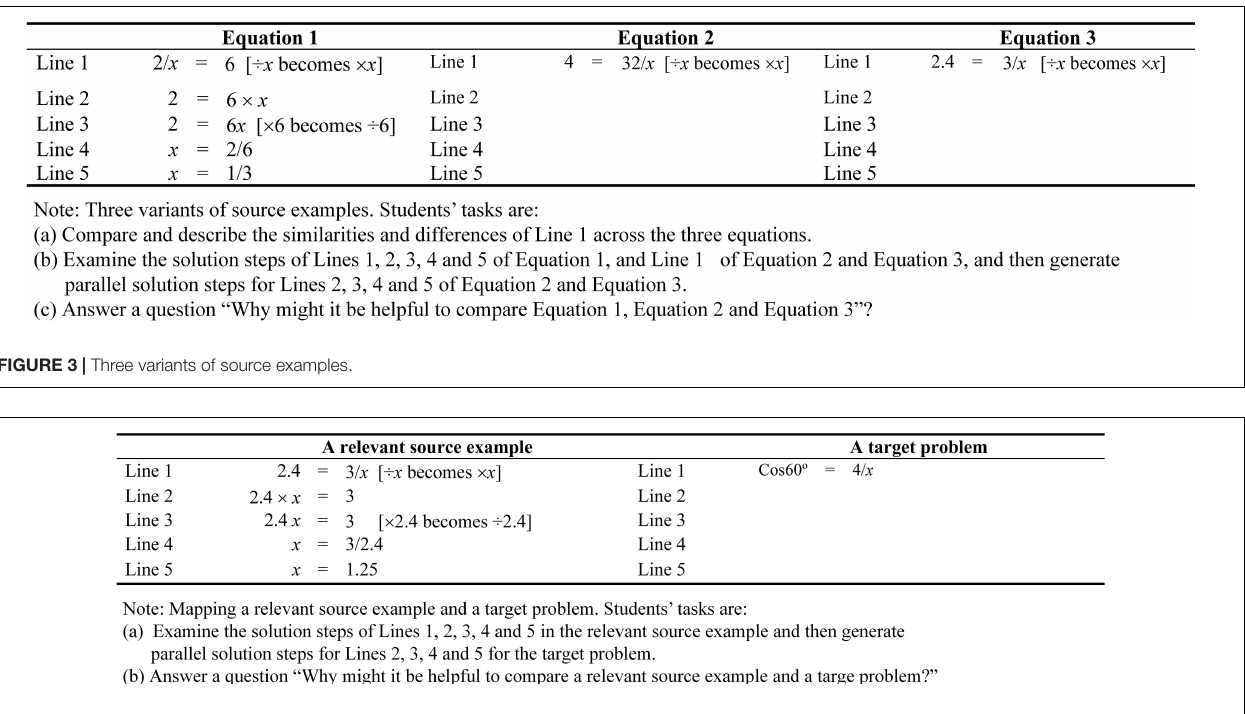
FIGURE 4 | Mapping a relevant source example and a target